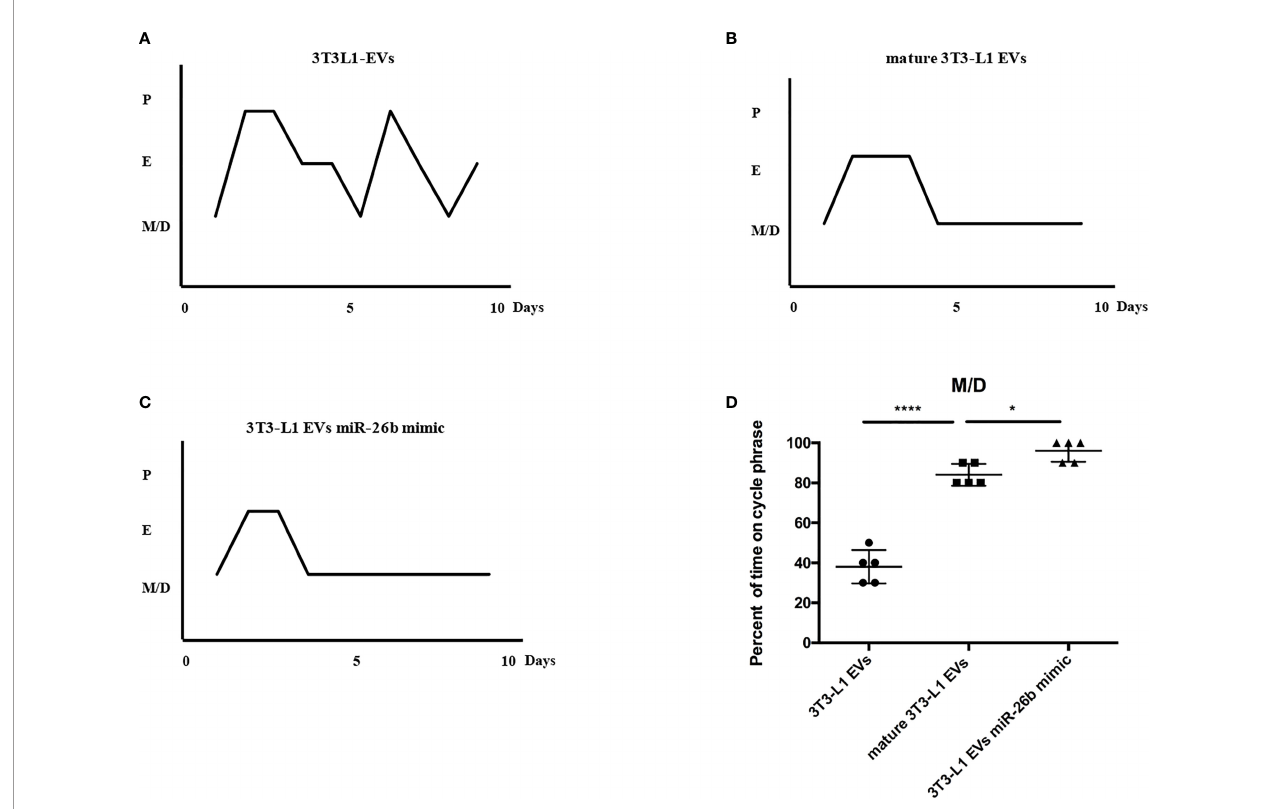
FIGURE 10 | Representative estrous cycles for mice from the three groups. (A) Representative estrous cycles for mice treated after 3T3L1-EVs. (B) Representative estrous cycles for mice treated after mature 3T3L1-EVs. (C) Representative estrous cycles for mice treated after 3T3L1-EVs miR-26b mimic. (D) Quantitative analysis of estrous cycles for the mice from the three groups; *p < 0.05, ****p < 0.0001.